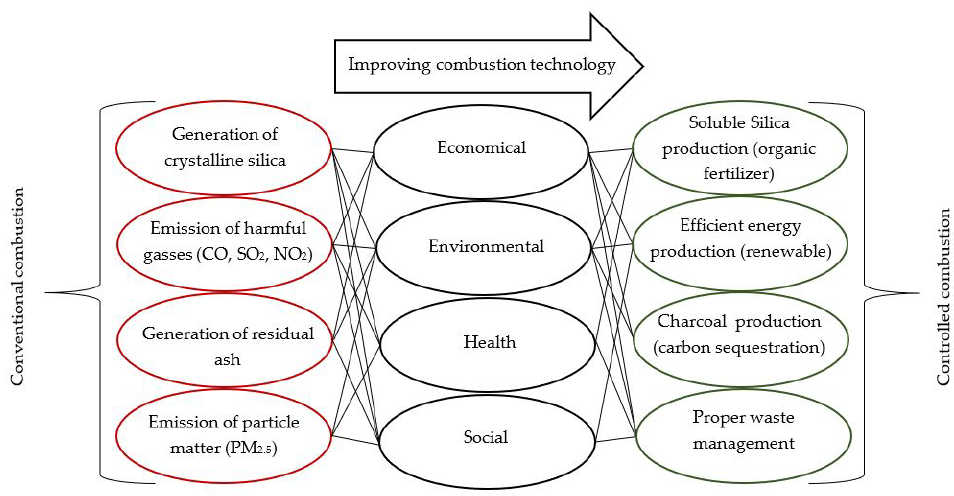
Figure 1. Importance of controlled rice husk combustion.